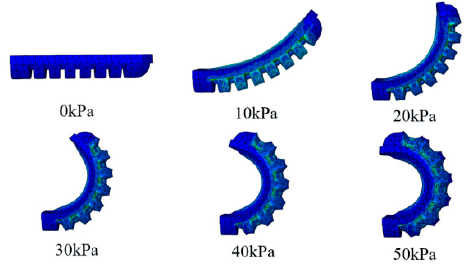
Figure 6. Simulation results of bending actuator.